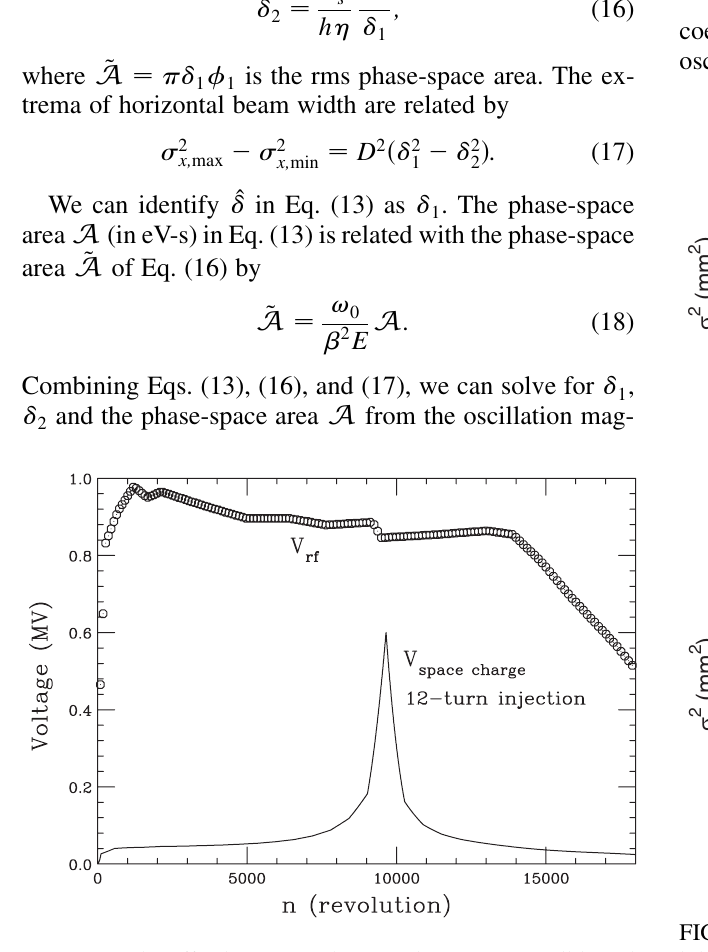
FIG. 20. The effective space-charge voltage V in the acceleration cycle. the V rf